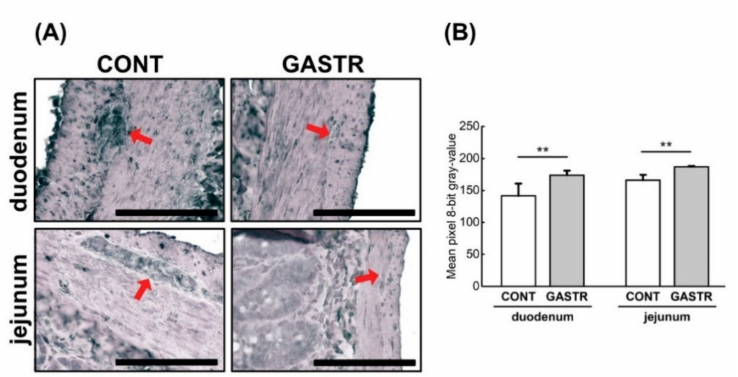
Figure 11. ( A ) Representative photomicrographs of the immunohistochemical reactions for vasoactive intestinal peptide (VIP) in Auerbach plexuses (red arrow) of the duodenum and the jejunum. Sections were developed in 3,3 (cid:48) -diaminobenzidine tetrahydrochloride with metal enhancer; counterstaining was performed with Nuclear Fast Red. All the scale bars represent 100 µ m. ( B ) The intensity of expression of VIP, measured by the quantitative assessment of mean pixel intensity values in the photomicrographs converted to 8-bit grayscale images. Scale from 0 (white pixel) to 255 (black pixel); the lower the pixel value, the higher the intensity of immunohistochemical reaction. Graph shows mean ± standard error. Significance was established using a two-tailed Student’s t -test (normally distributed data), Welch’s test (normally distributed data with unequal variances) or the Mann–Whitney test (for pairwise comparisons with at least one non-normally distributed dataset); ** p <